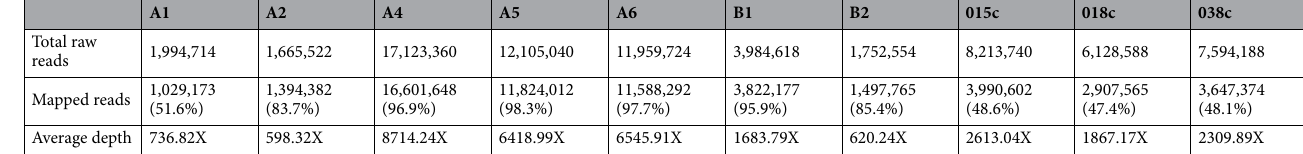
Table 2. Description of raw sequencing, mapping and assembly